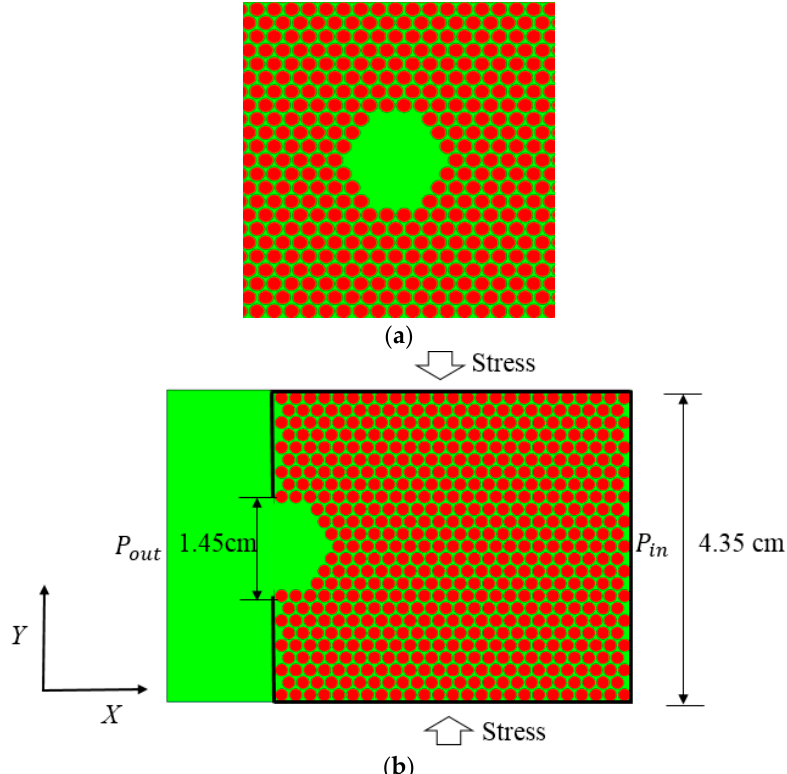
Figure 9. The cemented granular media used in sand production simulation. ( a ) The cross section of a single perforation in cemented reservoir; ( b ) the geometry of sample used in sand production simulation.